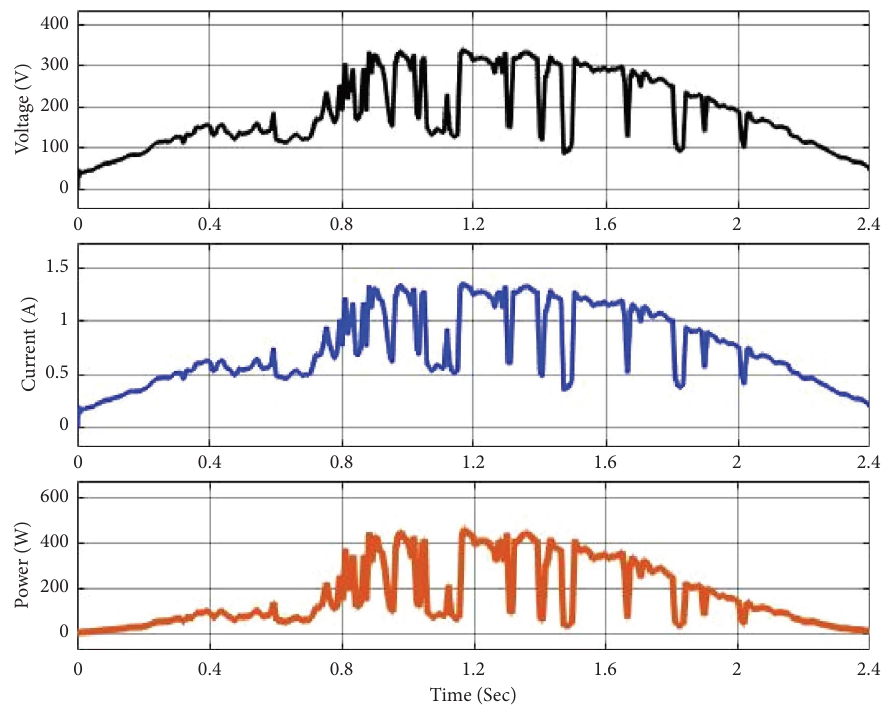
Figure 25: Output voltage, current, and power at load.